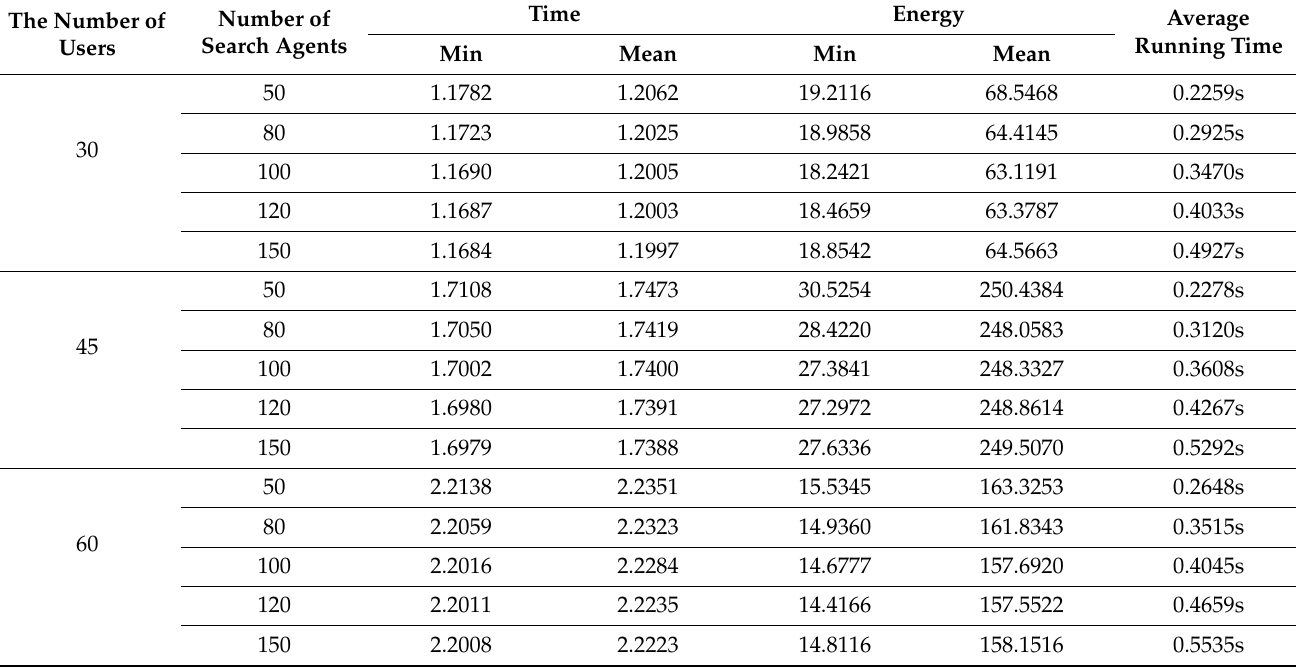
Table 8. The results of adjusting